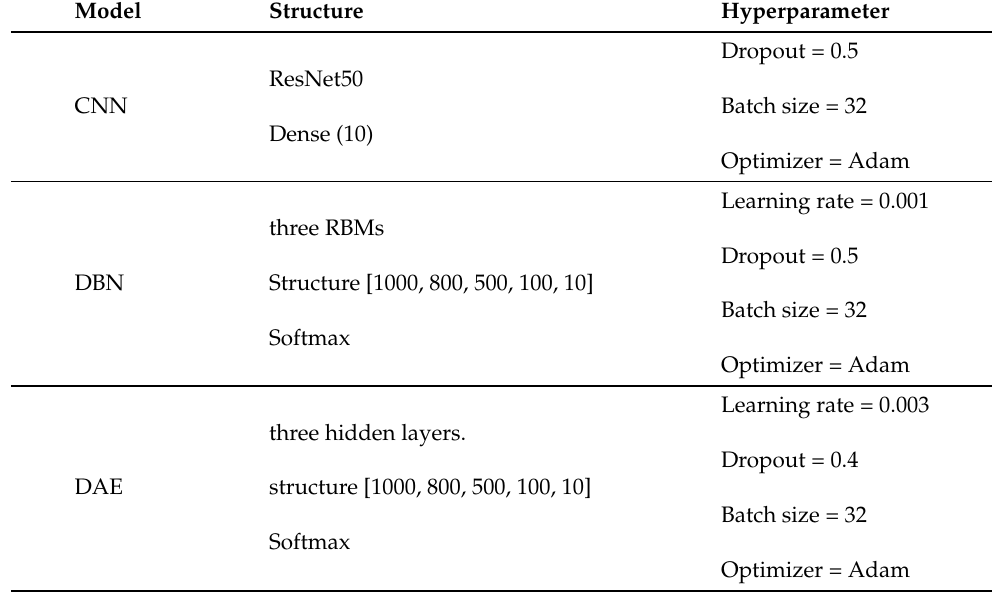
Table 4. Structure and hyperparameter